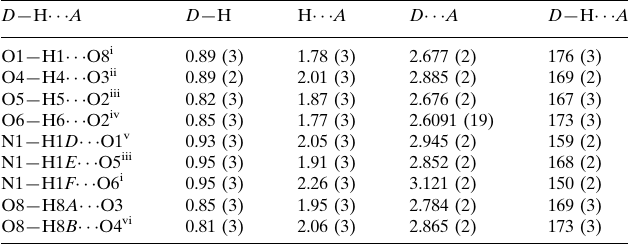
Hydrogen-bond geometry (A˚ , (cid:4) ). D —H (cid:1)(cid:1)(cid:1) A D —H